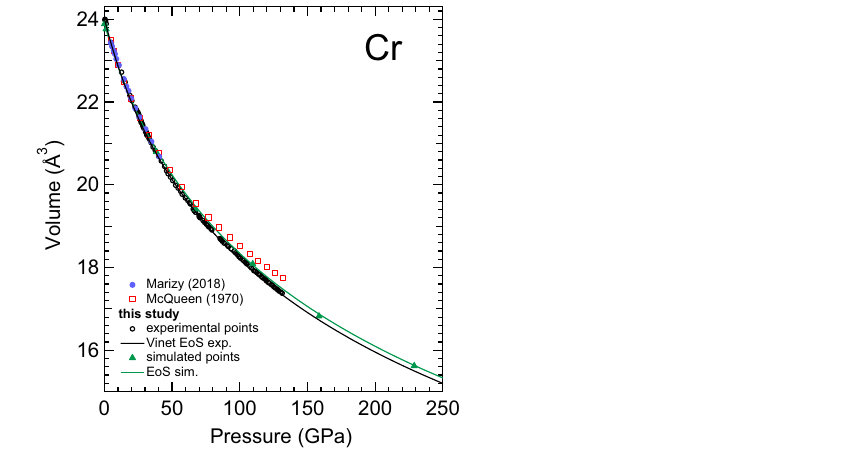
Figure 7. Measured and calculated unit-cell volume of Cr as a function of P compared with the shock data of McQueen 35 and the XRD data of Marizy et al. 34 . The Vinet EOS obtained from present experiments and calculations are also shown.